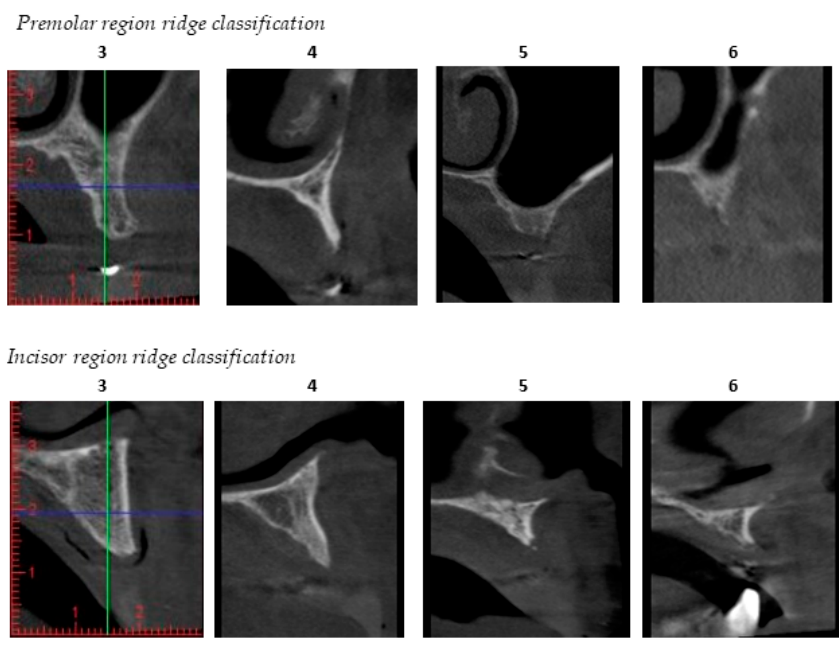
Figure 4. Cawood–Howell classification [23] of the maxillary alveolar ridge applied to cone-beam computerized tomography (CBCT) images in the patient population studied. This classification describes a progressive bone resorption pattern in 7 scores; score 1 being where a tooth is still present; and score 7 being extensive alveolar bone resorption. Score 3 and 4 represents bone which is sufficient in height, but too narrow in the crestal and midfacial zone (knife edge). Scores 5 to 6 show insufficient bone height and/or width to allow conventional implant placement without additional grafting procedures. Two examiners, the treating surgeon (L.V.D.) and the oral radiologist (G.H.), assessed all CBCTs independently to describe the quantity of available bone.